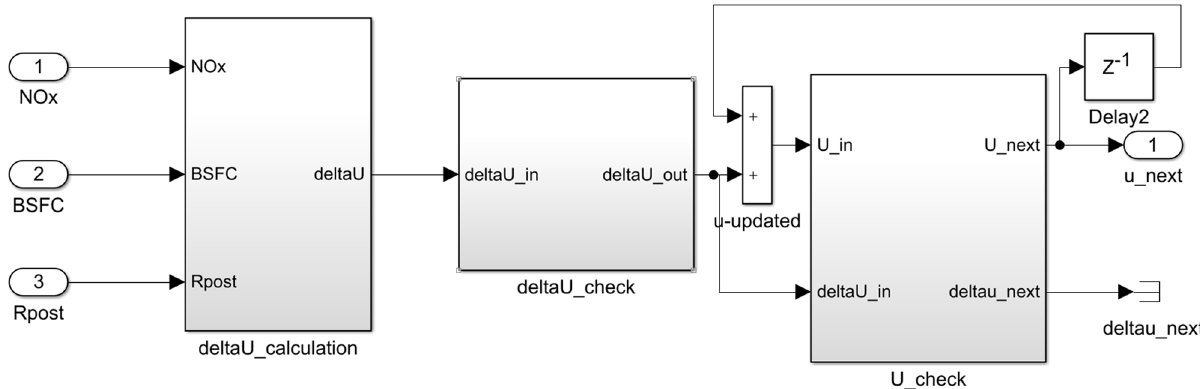
Figure 7: MPC simulation in Simulink